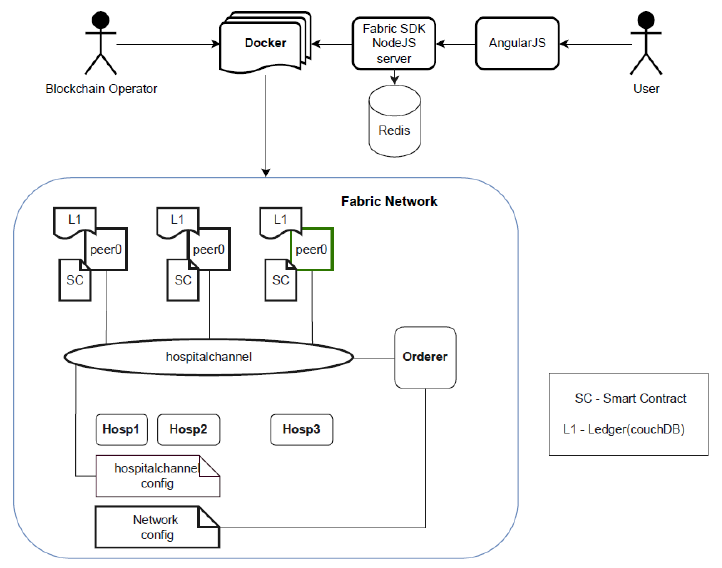
Figure 2. Overview of System Architecture.